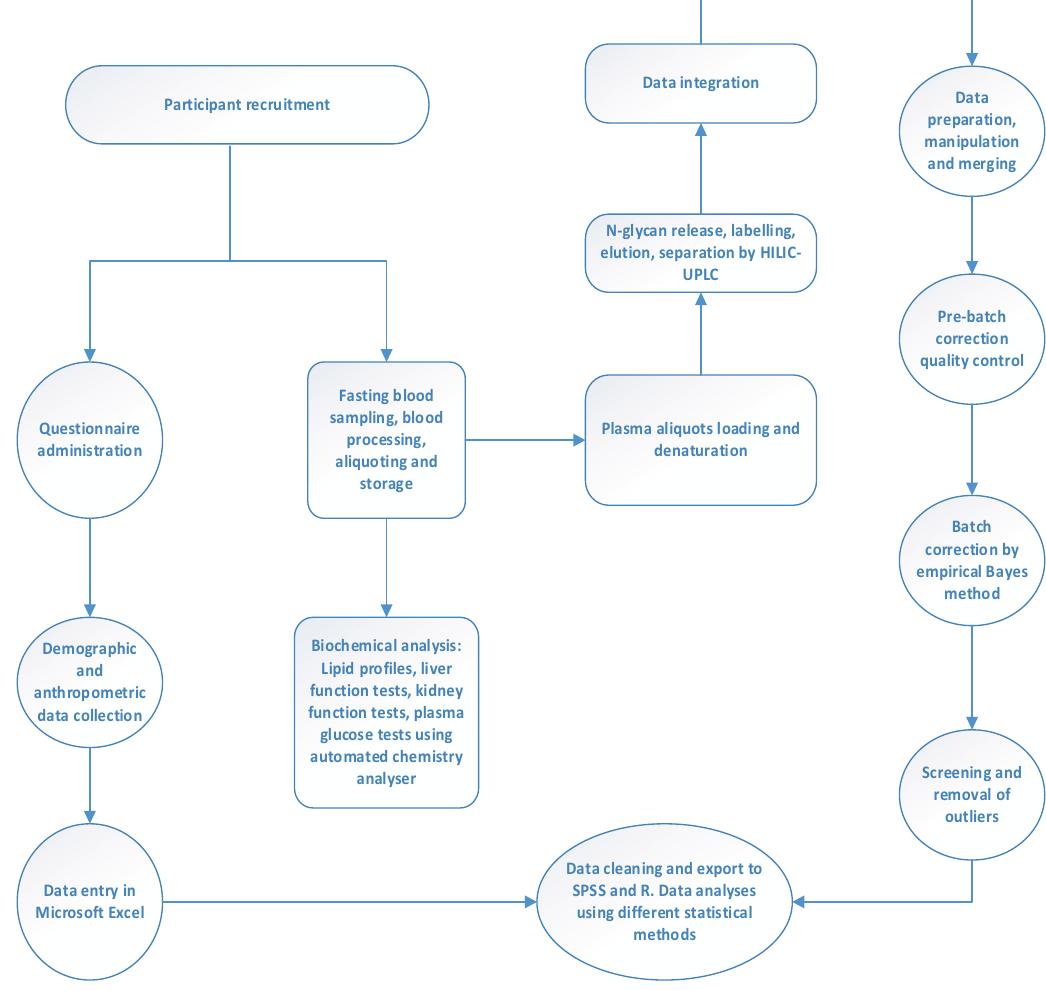
Figure 1. Flow chart of N-glycan data processing. Participants with no prior history of T2DM were recruited from the Kumasi metropolis. Ethics was approved and each participant was asked to complete a questionnaire. After this, demographic and anthropometric data were obtained, and fasting blood samples were collected for biochemical and N-glycan analysis. Statistical analyses were performed in SPSS and